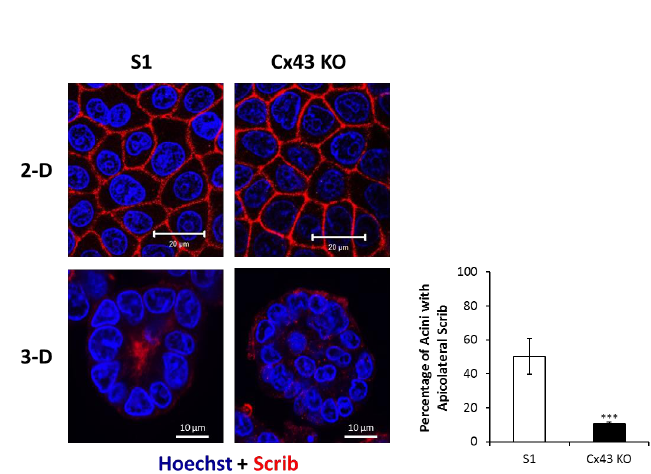
Figure 4. Silencing Cx43 alters the localization of junctional and polarity proteins in S1 cells under 3-D culture conditions without affecting their expression levels. S1 and Cx43-shRNA S1 cells (Cx43 KO) were cultured under 2-D or 3-D conditions. A. Total proteins were extracted on day 9 in 2-D (left panel) and on day 11 in 3-D (right panel). Expression of Scrib, ZO-2, β-catenin and Cx43 was assessed by Western blotting. Lamin B served as loading control. Three independent experiments were performed. The values depicted in the histogram (right panel) are the means of fold change in Cx43 expression in 3-D normalized to that of Lamin B from three independent experiments. Fold change in normalized expression is set to 1 in S1 cells. B. Localization of β-catenin (red) was assessed by immunofluorescence on day 9 in 2-D (left upper panel) and on day 11 in 3-D (left lower panel). Nuclei were counterstained with Hoechst (blue). The values depicted in the histogram are the means (± S.D.) of acini percentages with apicolateral β-catenin from three independent experiments. One hundred acini were analyzed per group. Unpaired t-test; **p < 0.01. C. Localization of Scrib (red) was assessed by immunofluorescence on day 12 in 2-D (left upper panel) and on day 11 in 3-D (left lower panel). Nuclei were counterstained with Hoechst (blue). The values depicted in the histogram are the means (± S.D.) of acini percentages with apicolateral Scrib from three independent experiments. One hundred acini were analyzed per group. Unpaired t-test; ***p < 0.001.